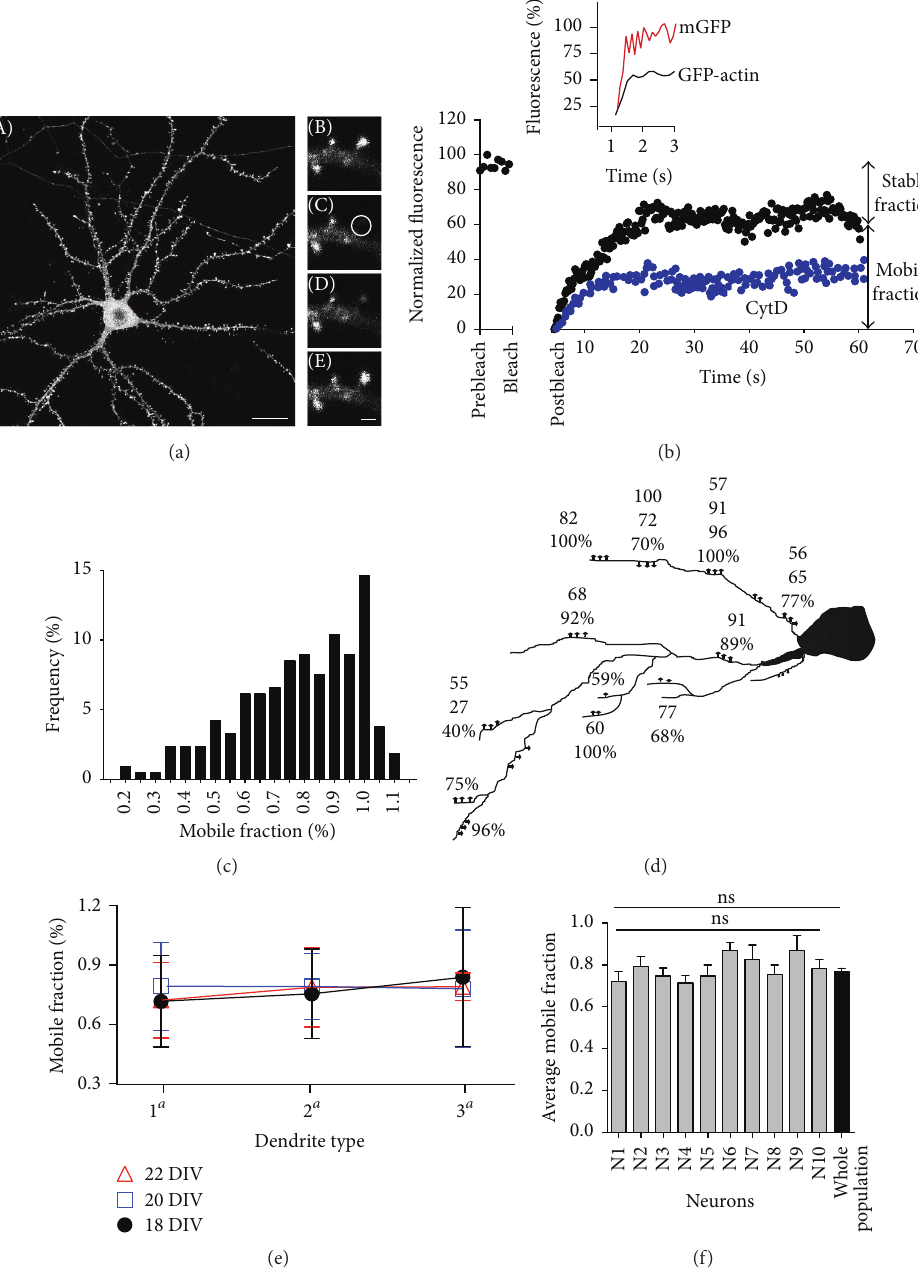
Figure 1: Mobile fraction values do not correlate with culture age or dendrite localization. (a) (A) An example of hippocampal neurons (growing in the presence of astrocytes) transfected with GFP-actin. Scale bar: 20 𝜇 m. Pictures on the right (B to E) are higher magnification images showing prebleach (B), bleach (C), postbleach (D), and late phase of recovery (E) (60 s). Scale bar: 1 𝜇 m. (b) Normalized fluorescence recovery curve of (a), showing the two fractions of fluorescence recovery: stable and mobile fractions ( 𝑛 = 212 spines, black circles). An example of the recovery in the presence of Cytochalasin D (CytD) (5 𝜇 M) in the extracellular solution ( 𝑛 = 4 spines, blue circles). Top insert: comparison of the initial phase of GFP-actin (black line) and monomeric GFP (red line) recovery curves. Note the similarities between both initial phases in the first 1–3ms. (c) Graph frequency distribution of mobile fractions from neurons 20 DIV growing in the presence of astrocytes. Mean average was 0.78 ± 0.01 ( 𝑛 = 10 neurons, 𝑛 = 5 independent cultures, and 𝑛 = 212 spines). (d) Neuronal structure drawing indicating the localization of the recorded spines. Note the variability in MF values along neuronal dendrites. (e) Mobile fraction values were averaged according to their dendrite type (primary, secondary, or tertiary), and the same value was calculated at days 18, 20, and 22 in vitro ( 𝑛 = 10 neurons, 𝑛 = 5 independent cultures, mean ± SEM). As the graph shows, no differences were found for culture age or dendrite localization (two-way ANOVA with Tukey’s multiple comparison test, ns). (f) Average mean of mobile fraction values from ten individual neurons was compared with the overall population of MF mean. No statistical differences were found among neurons or when each neuron was independently compared to the whole population. Only values from 20 DIV were used in this analysis (one-way ANOVA, ns) ( 𝑛 = 10 neurons, 𝑛 = 5 independent cultures, mean ±